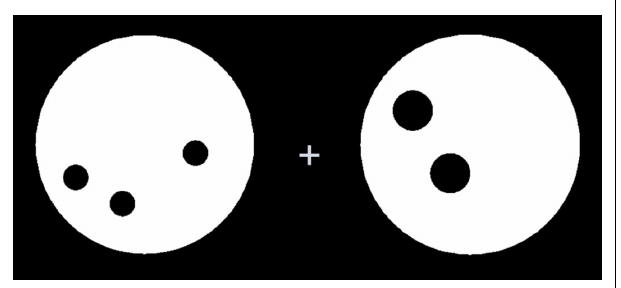
FIGURE 1 | Example stimulus of the exact non-symbolic addition task with equal overall area of dots for both